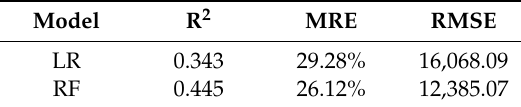
Table 5. Model accuracy in dense area.